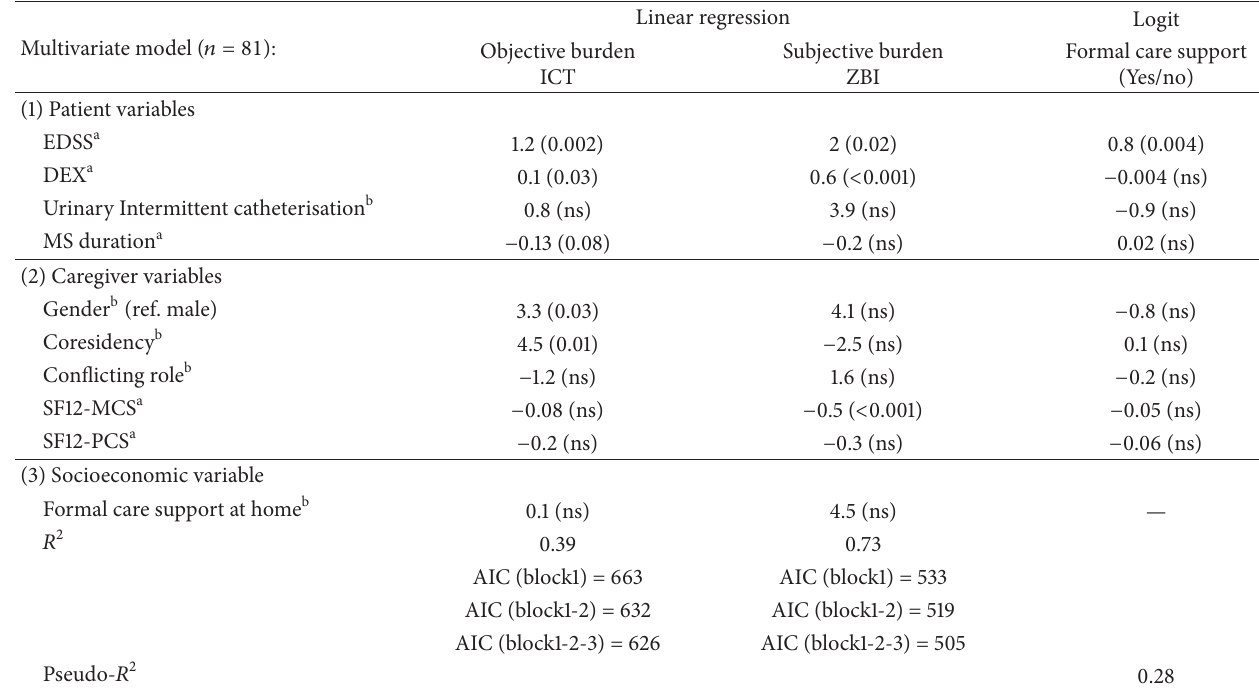
Table 3: Factors associated with informal care burden and with formal care